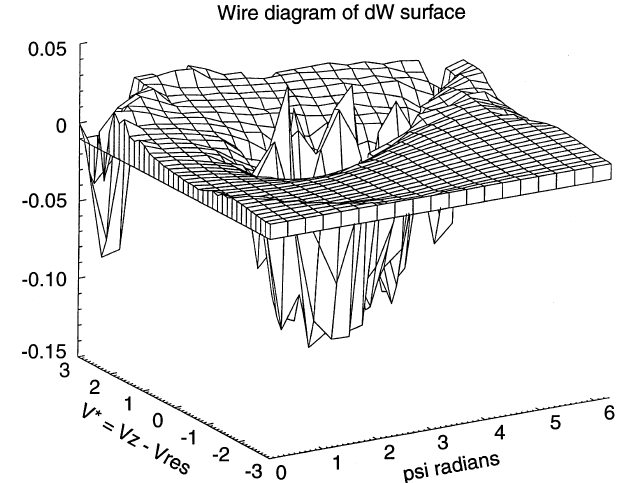
Fig. 13. Case B. Wire diagram representation of D W in the V (cid:3) = w plane for the faller, at t = 1.5 s and at z = ) 1000 km. The trapped